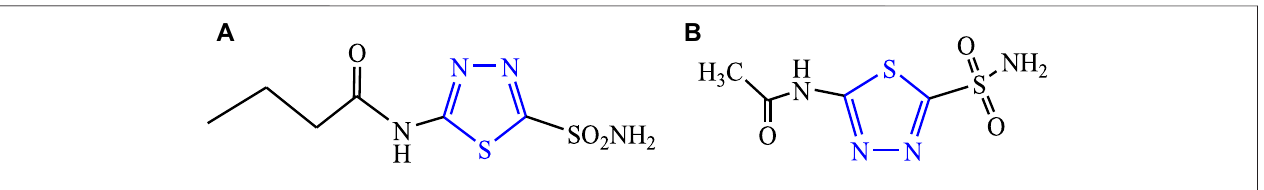
FIGURE 3 | (A) Butezolamide. (B)